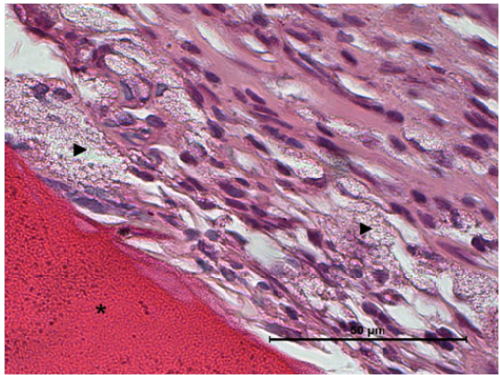
Figure 7. Histological evaluation of CS/Sol-Si biocomposite and pure chitosan (CS) at 1 day post-implantation in the hematopoietic bone marrow compartment. ( a – c ) Show the biocomposite composed of chitosan (*) and the silica particles ( ► ). ( d ) shows only CS. All cases show the clot covering the entire surface of the biomaterial. ( a ) Orig. Mag. ×50; ( b ) Orig. Mag. ×100; ( c , d ) Orig. Mag. ×400. H–E stain. CS/Sol-Si ( a – c ). CS ( d